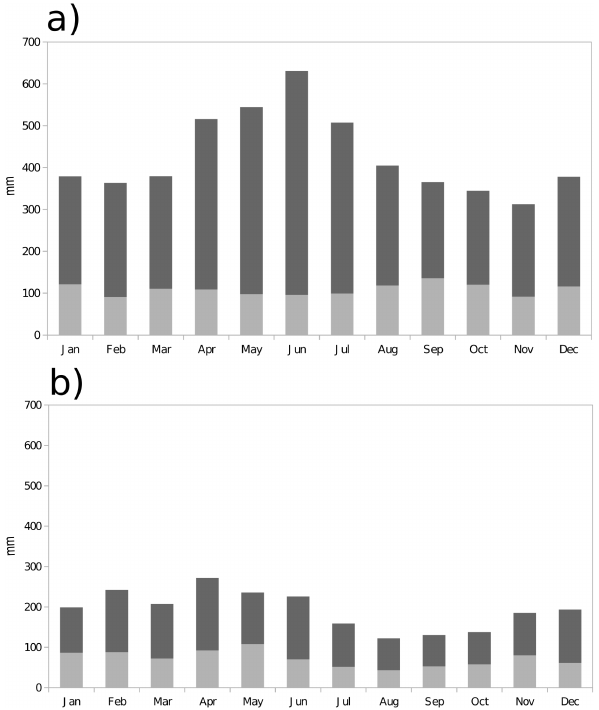
Figure 2. Rain (dark grey) and occult precipitation (OP) (light grey) monthly means for (a) Cerro del Consuelo and (b) El Tiro meteoro- logical stations